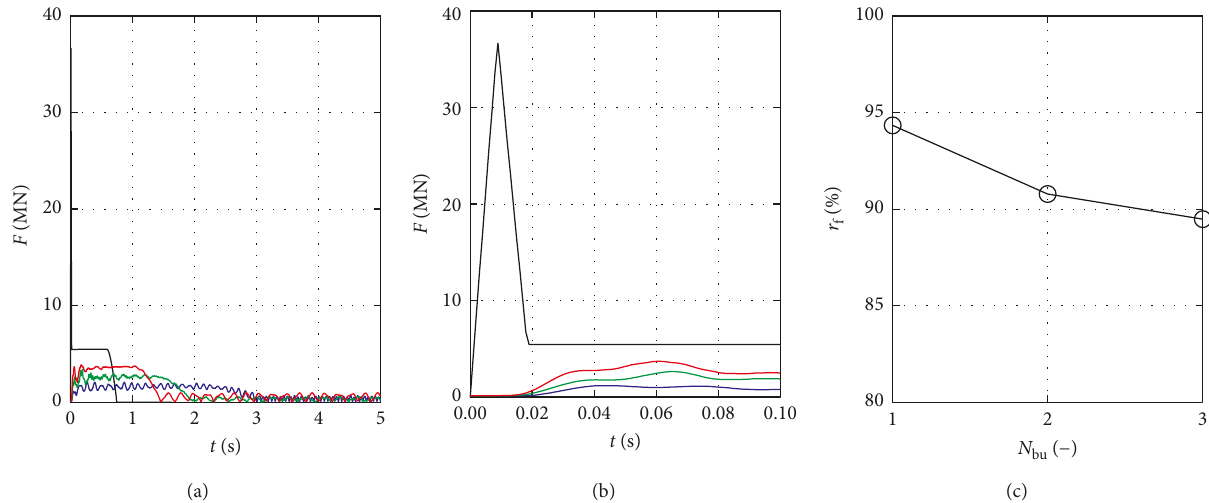
Figure 17: Impact force time histories on the bridge pier for the whole impact process (a), for the first 0.10s of impact process (b) corresponding to different beam unit numbers, and the reduction ratio of maximum impact force versus beam unit number N bu (c). , without the device; Table 2: Relationships of I cross-section dimensional parameters. Table 3: Impact scenarios considered for structure Ratio Value (–)